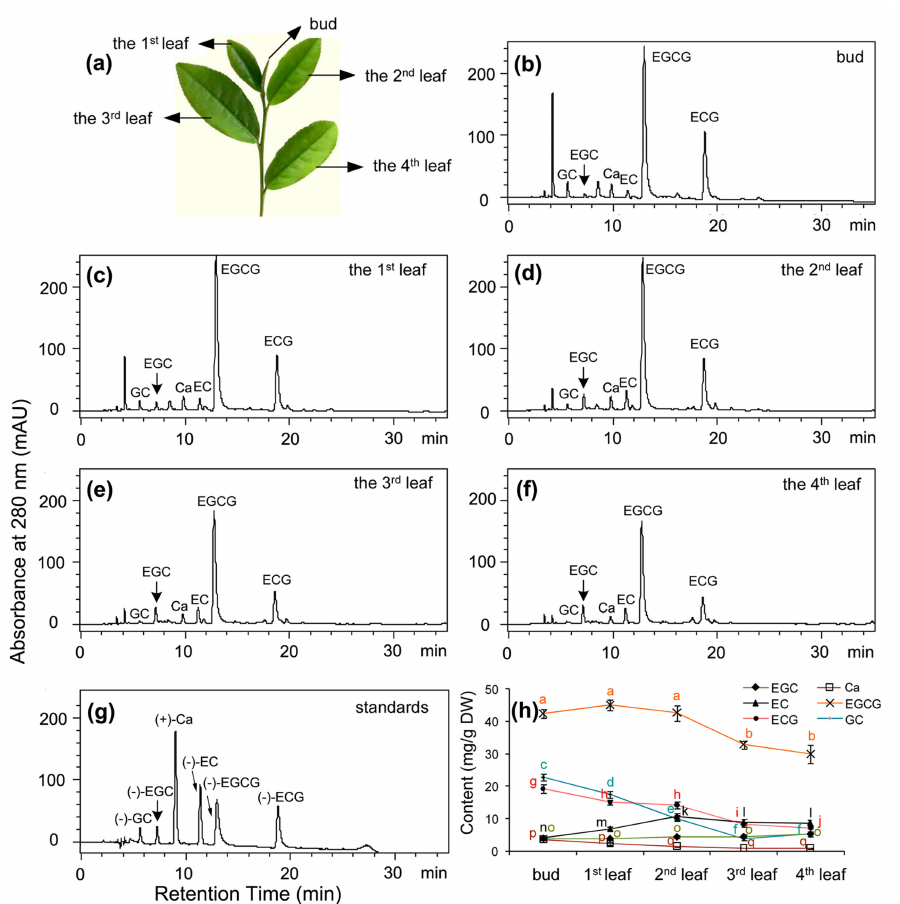
Figure 2. Flavan-3-ol profiles in leaves of 10-year-old Shuchazao plants grown in the field. ( a ) leaf morphologies on a new branch in spring; ( b – e ) HPLC profiles showing flavan-3-ols from buds ( b ), the 1st leaf ( c ), the 2nd leaf ( d ), the 3rd leaf ( e ), and 4th leaf ( f ). ( g ) standards, (+)-Ca: catechin, ( − )-EC: ( − )-epicatechin, ( − )-GC: ( − )-gallocatechin, ( − )-EGC: ( − )-epigallocatechin, ( − )-ECG: ( − )-epicatechin-3-gallate, and ( − )-EGCG: ( − )-epigallocatechin-3-gallate; ( h ) contents of six metabolites in leaves and buds (on each colored line, points labeled with different low case letters mean significant difference, p -value less than 0.05, while labeled with the same ones mean insignificance, p -Value higher than 0.05. p -values were calculated with Student’s t